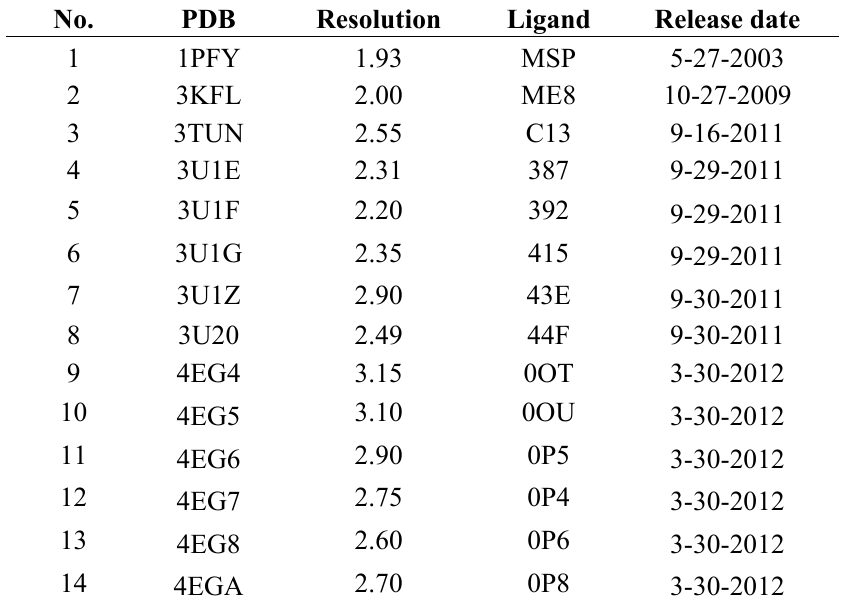
Table 3. List of fourteen MetRS-inhibitor complexes used in the study.